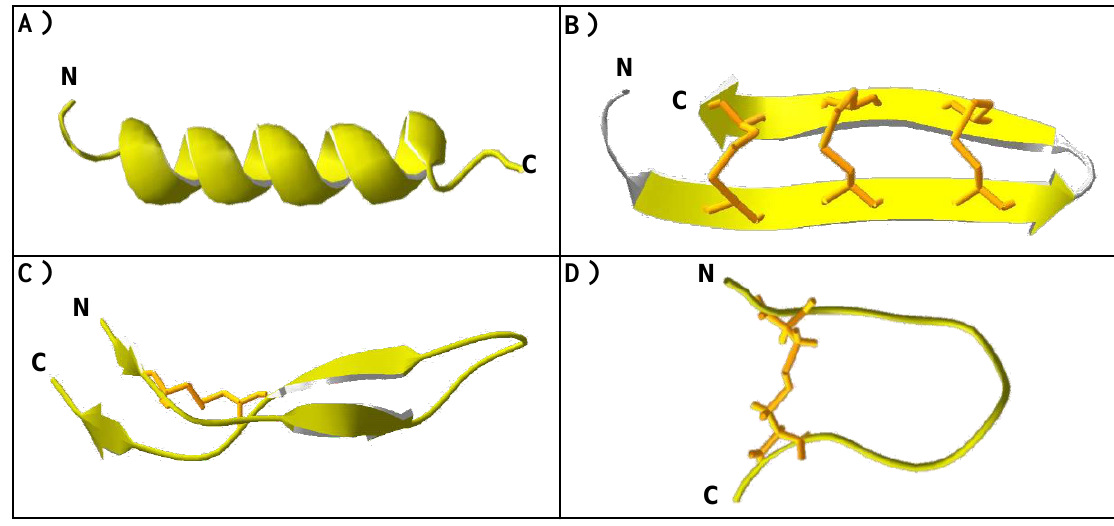
FIGURE 1. (A) The α-helical peptide pleurocidin from the mucus membranes of winter flounder. (B) Retrocyclin-2, a circular minidefensin with significant potential as an agent against HIV, influenza A, and herpes simplex virus, whicht forms a β-hairpin